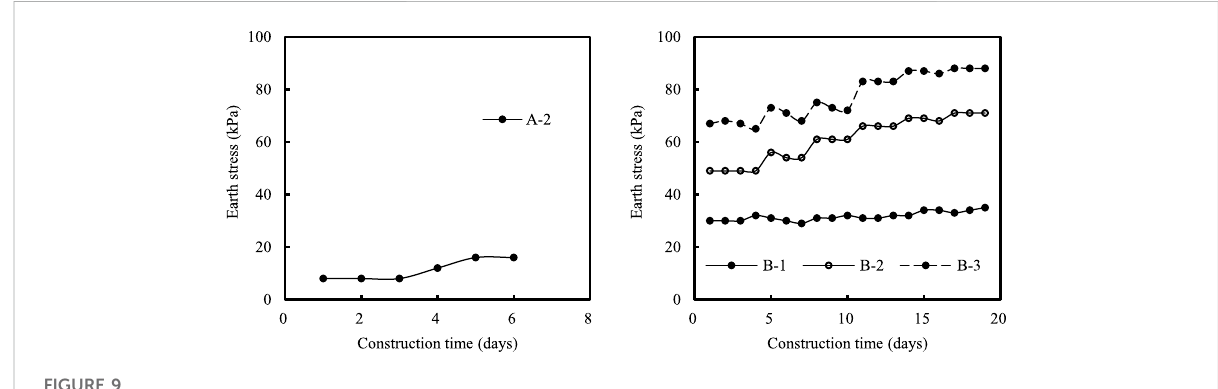
FIGURE 9 The lateral earth pressure at different pile depths versus the construction